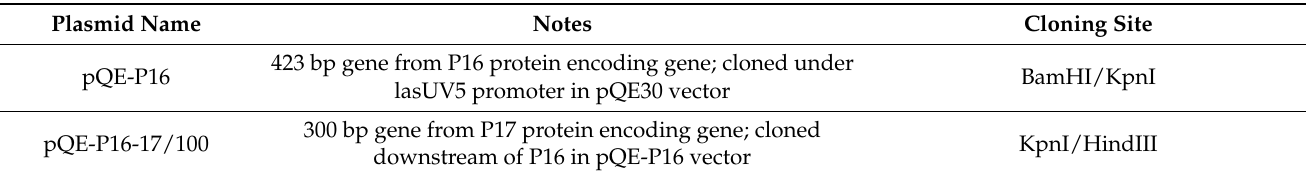
Table 2. Plasmids constructed for this